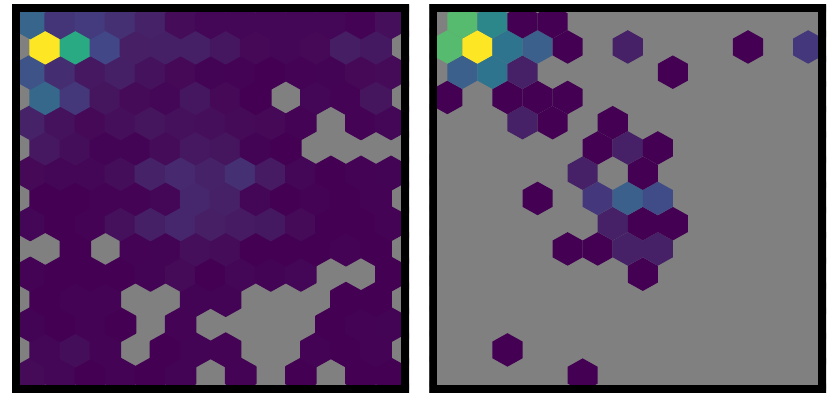
Figure 5. Hexagonal heatmaps showing the two-dimensional distribution of the location of initial target selections. Grey areas indicate cells with a count of 0. The left panel shows the distribution over all initial target selections (i.e., multiple trials per participant) while the right panel shows the distribution of each participant’s median initial selection (i.e., each participant contributes one data point to the